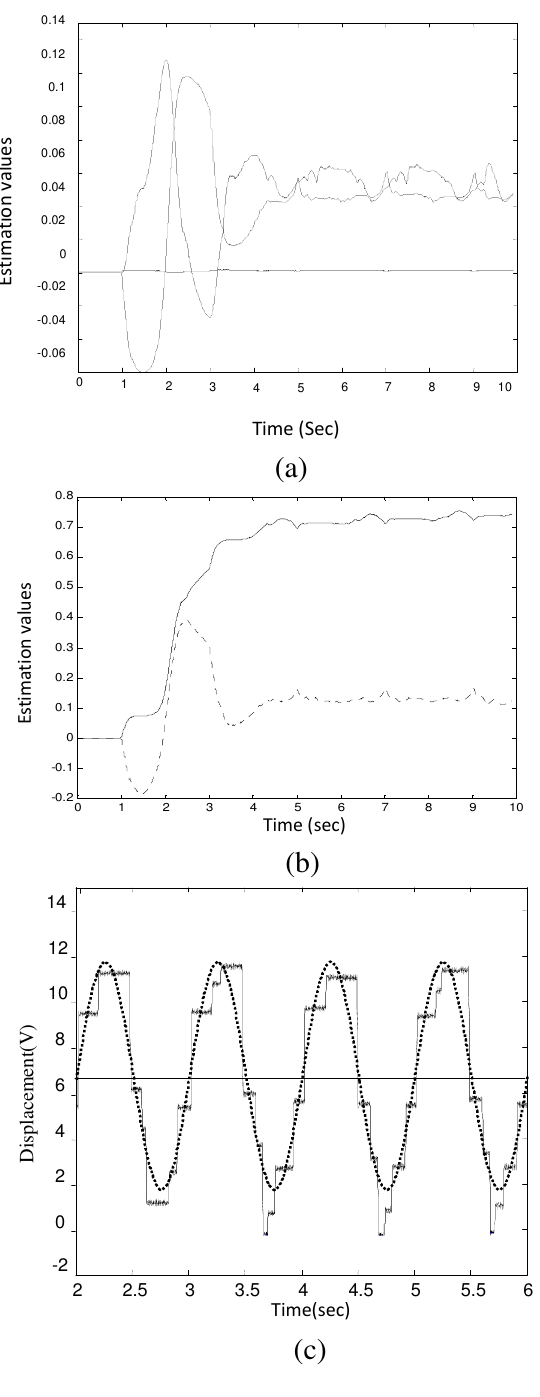
Figure 5. Parameter identification for valve V line; (b) â : solid line, â : dot line; (c) the tracking signal (solid line) and the reference input f 0 (dot line) during